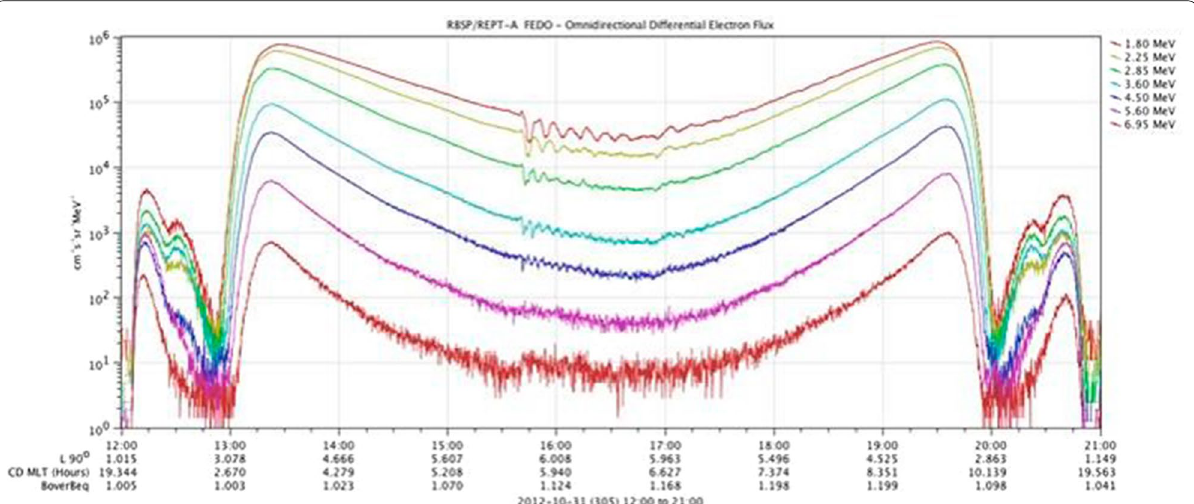
Fig. 1 Observations from the Relativistic Electron–Proton Telescope (REPT) instrument on board the RBSP-A spacecraft for the period 1200–2100 UT on 21 October 2012. Measurements cover the electron energy range from E curves. A shock wave struck the Earth’s magnetosphere at ~ 1540 UT causing abrupt oscillatory flux variations as discussed in the